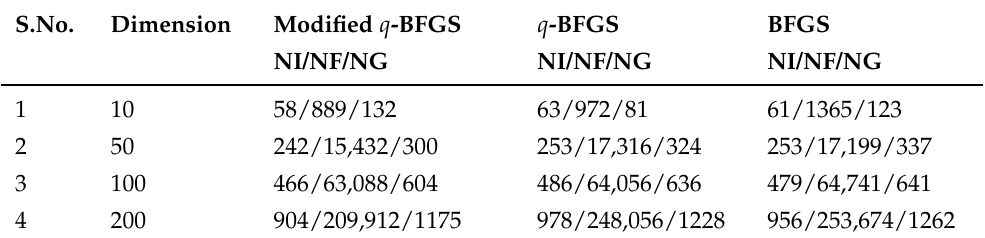
Table 5. Comparison of numerical results of Modified q -BFGS, q -BFGS, and BFGS algorithm for the large dimensional Rosenbrock function.